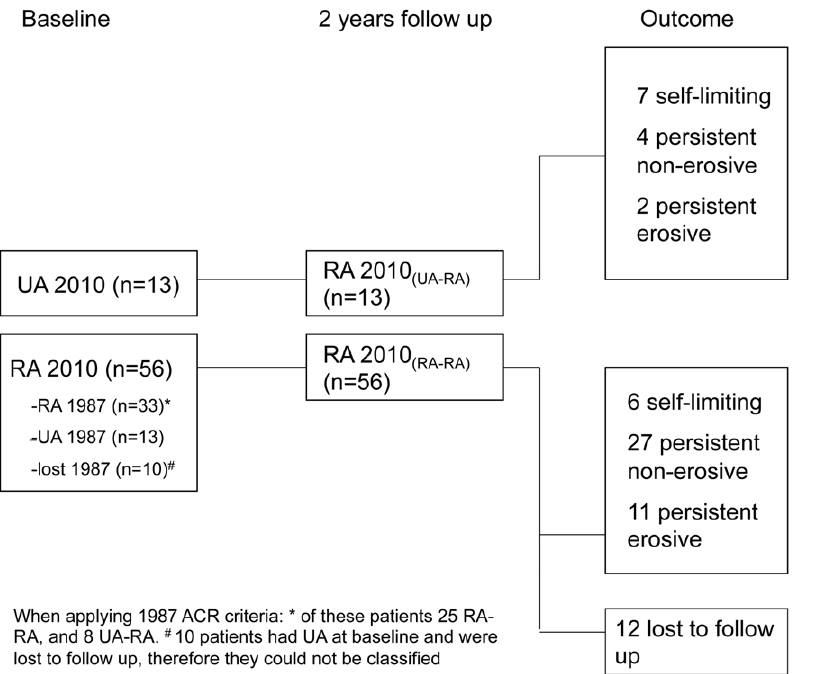
Figure 1. Patient classification. Patient classification at baseline and after 2 years follow up according to 2010 ACR/EULAR criteria, and according to outcome after 2 years follow up.